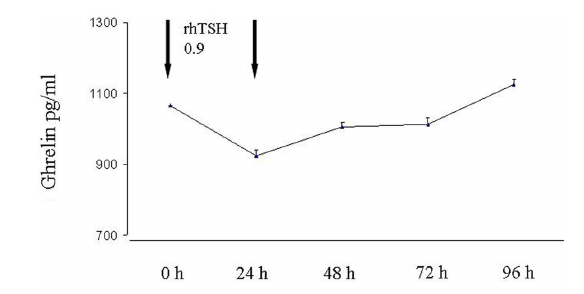
FIGURE 1 | Changes of serum ghrelin concentrations after rhTSH stimulation.